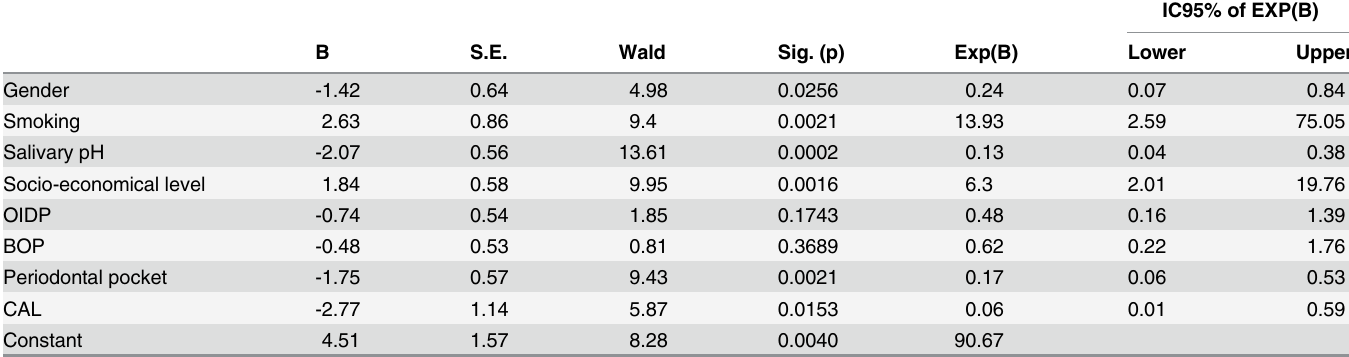
Table 4. Logistic regression parameters among obesity and other categorical